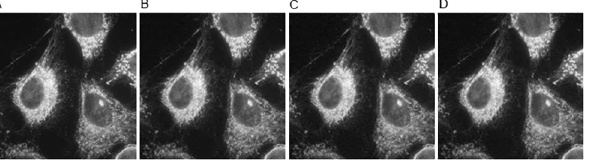
Fig 5. The reconstructed results of different methods on CIL 248 image from noisy and undersampled Fourier data (noise level: 30 dB and sampling ratio: 50%). (A) Original image; (B) TV-FISTA result; (C) HDTV2-MM result; (D) HDTV2-FBS